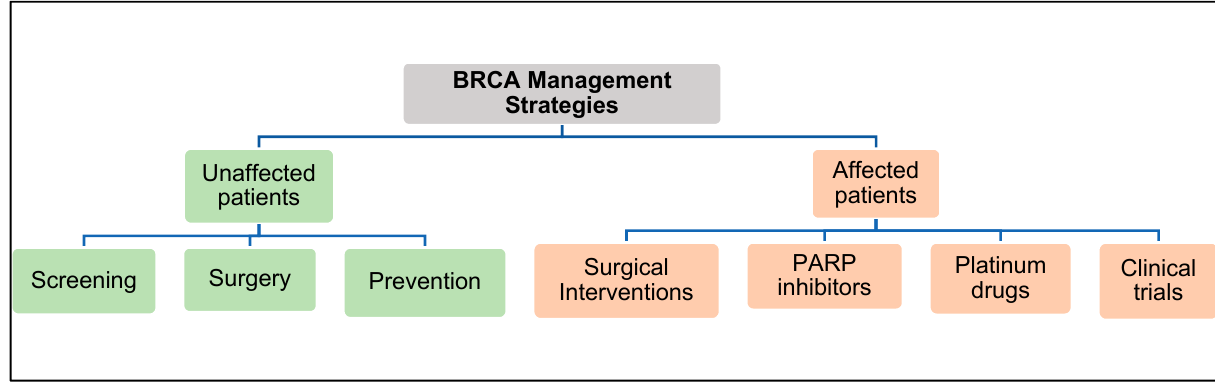
Figure 6. BRCA2 Management Strategies.